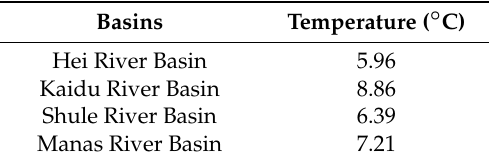
Table 10. Areal average daily average temperature in summer of selected